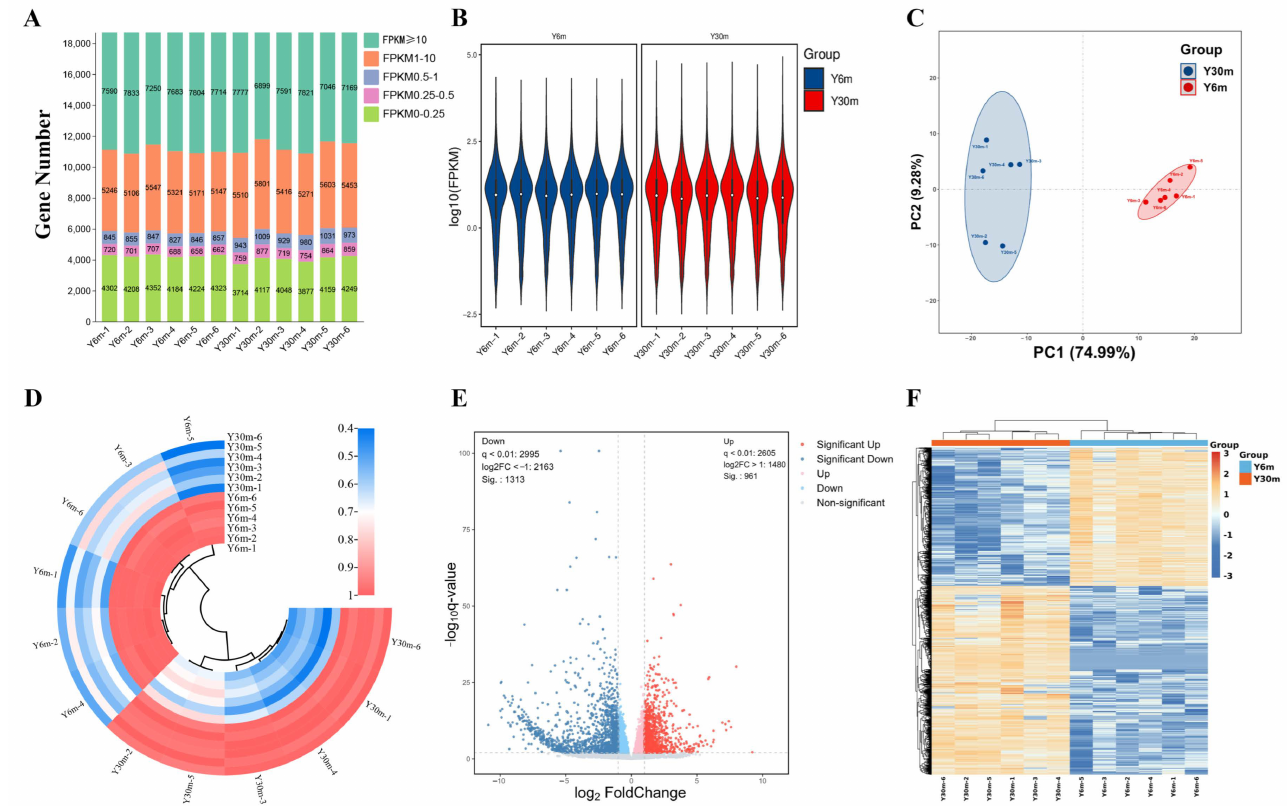
Figure 2. RNA-seq data summary. ( A ) The expression distribution of FPKM in each sample. ( B ) FPKM violin diagram. ( C ) PCA diagram. ( D ) Correlation heatmap and cluster analysis among samples. ( E ) Gene volcano map of the difference between 6m and 30m groups. ( F ) Cluster analysis of different gene groups. Y6m: 6-month-old group. Y30m: 30-month-old